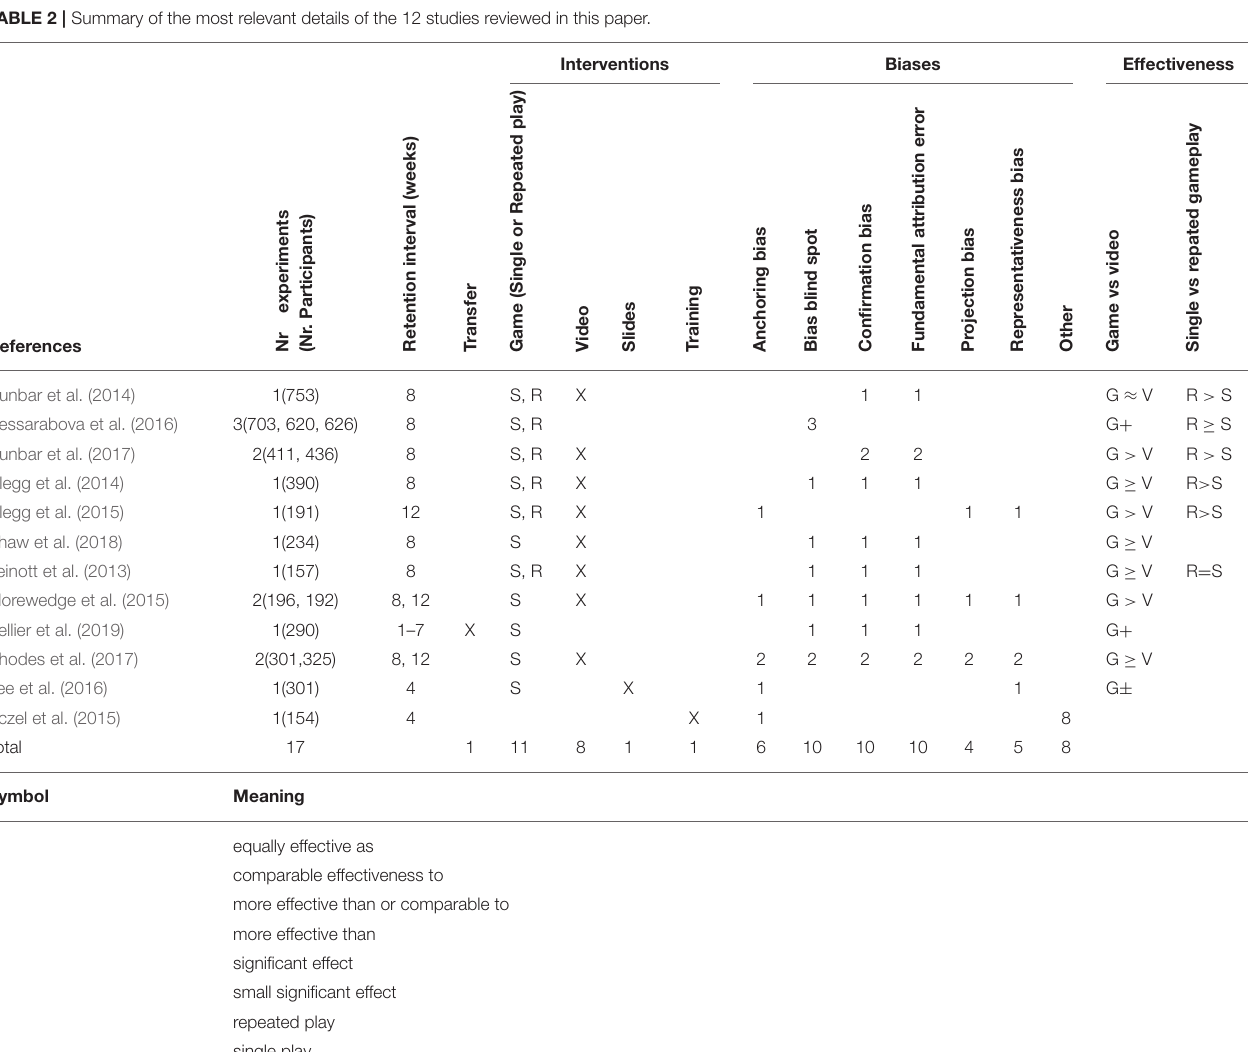
TABLE 2 | Summary of the most relevant details of the 12 studies reviewed in this